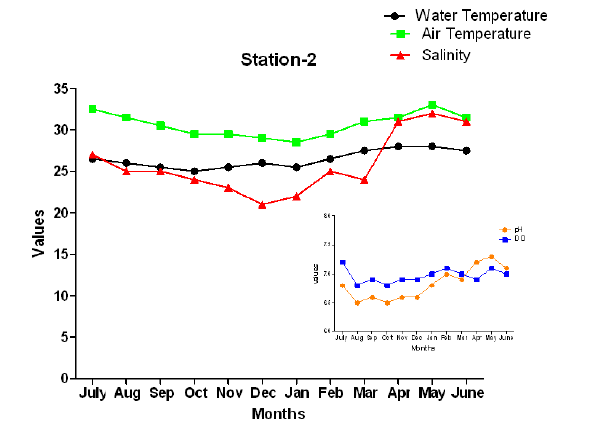
Fig. 3. Hydrographical features at station-2 (Pandi backwaters) during July 2006-June